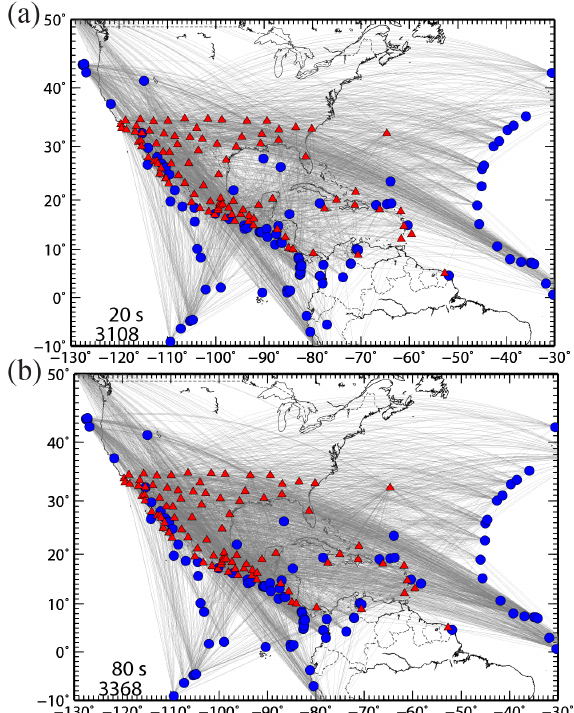
Figure 2. Path distribution of Rayleigh-wave group velocities at (a) 20s and (b) 80s period. Red triangles denote broadband seismic sta- tion locations and blue circles the earthquake epicenters. The num- ber on each map indicates the number of